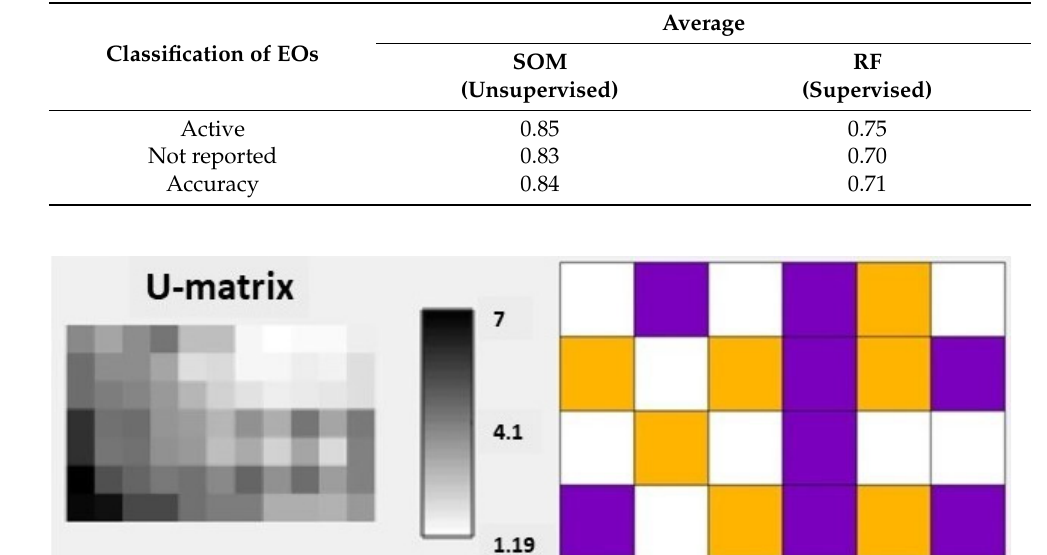
Table 3. Summary of test averages corresponding to 5-fold cross-validation using the different ma- chine learning algorithms, self-organizing maps (SOM) and random forest (RF).